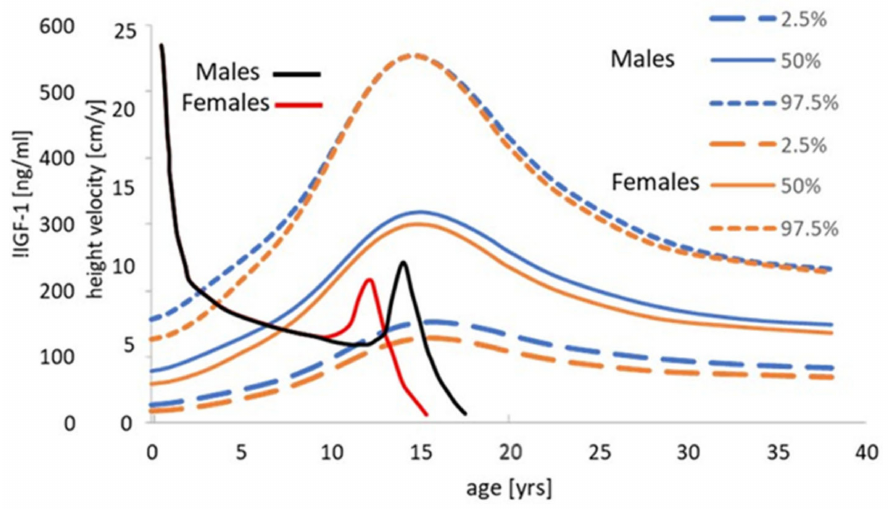
Figure 15. Serum IGF-1 and height velocity curves for males and females from birth to middle age [370]. It is clear that the overall pattern of changes in serum IGF-1 does not reflect height velocity apart from in puberty and even then, peak height velocity precedes peak IGF-1 by 2 years. Reference serum IGF1 percentiles for males and females calculated for a multicentre study with samples from 12 cohorts from the United States, Canada, and Europe ( n = 15,014 subjects, 6697 males, 8317 females), with values obtained with an automated chemiluminescence IGF-I immunoassay. Values at birth from cord blood. Values drawn from Bidlingmaier et al. [370]. Height velocity curves for a cohort of Italian boys and girls